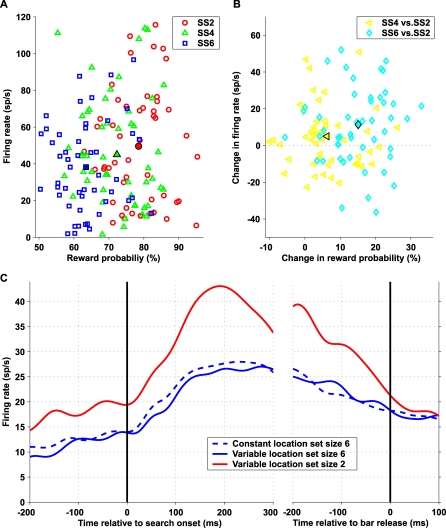
Firing Rates Are Not Correlated with Reward or Target Location Probability(A) Within set-size analysis. Each neuron's average firing rate (100–200 ms after search onset, target in RF, correct trials) is plotted as a function of reward probability in the corresponding trial block. The average firing rates were 49.6 ± 4.4, 44.7 ± 4.3, and 38.2 ± 3.5 spikes/s for set sizes 2, 4, and 6 (p < 0.05, one-way ANOVA). Overall correlation was not significant (r = 0.11, p = 0.2).(B) Across set-size analysis. The difference in average firing rates at set-size 2 versus set-size 4 (triangles), and set-size 2 versus set-size 6 (rhombuses) as a function of the corresponding differences in reward probability. Differences are calculated using data on correct trials in which the target appeared in the RF. The correlation coefficient for the entire dataset was not significant (r = 0.0001, p = 0.99). The average values ± standard errors for changes in reward probabilities were 6.2 ± 1.3 % and 15.1 ± 1.2 % for set-size 2 vs. 4 and set-size 2 versus 6, respectively; the corresponding changes in firing rates were 5.0 ± 3.2 and 11.3 ± 3.2 spikes/s.(C) Average firing rates (n = 10 neurons) when the target was in the RF, for set-size 6 (blue) with 100% (dashed) and 16.7% (solid) location probability, and for set-size 2 (red) with 50% location probability.